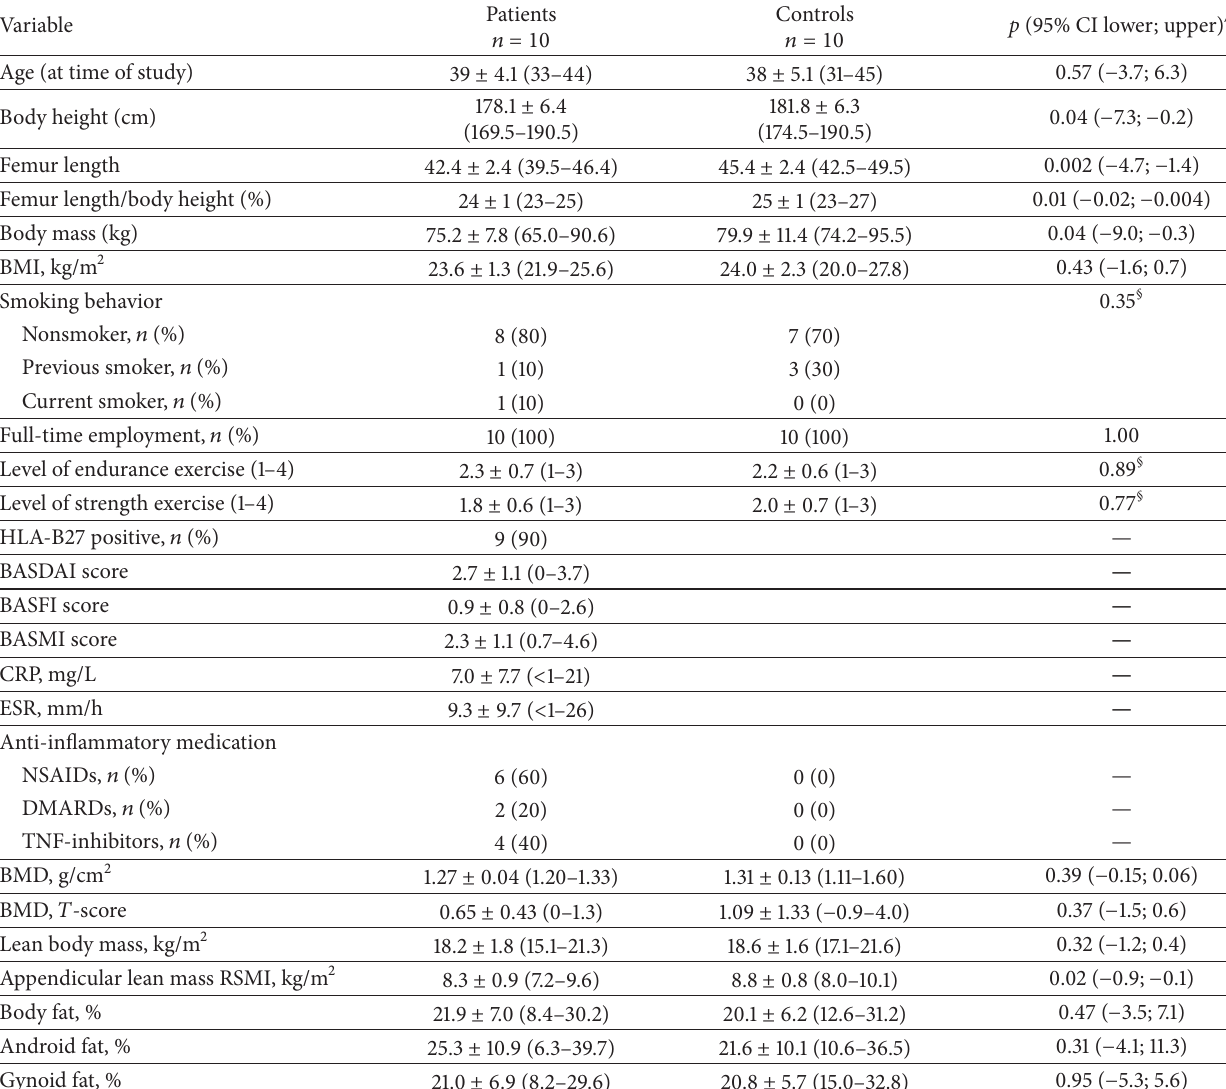
Table 1: Subject characteristics ∗